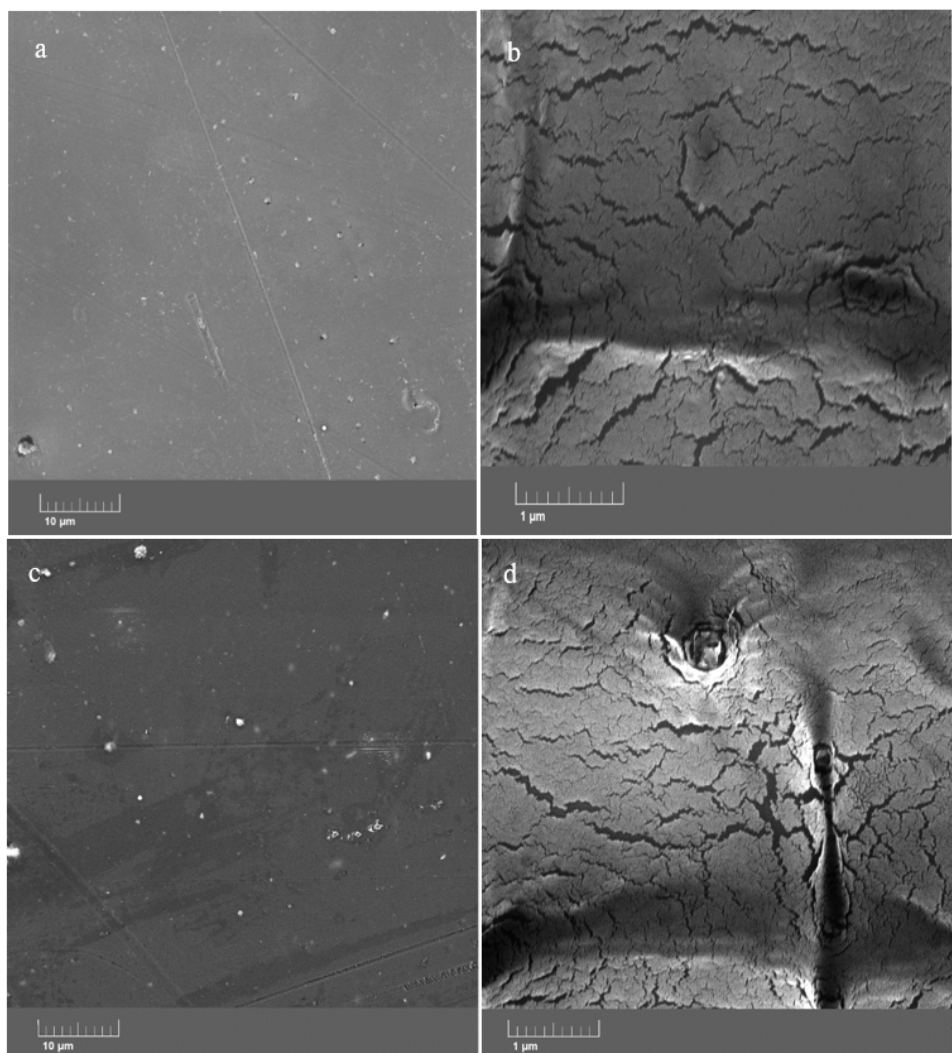
Figure 6. FESEM images of the neat ( a , b ) and ZHS ‐ containing ( c , d ) epoxy coatings.